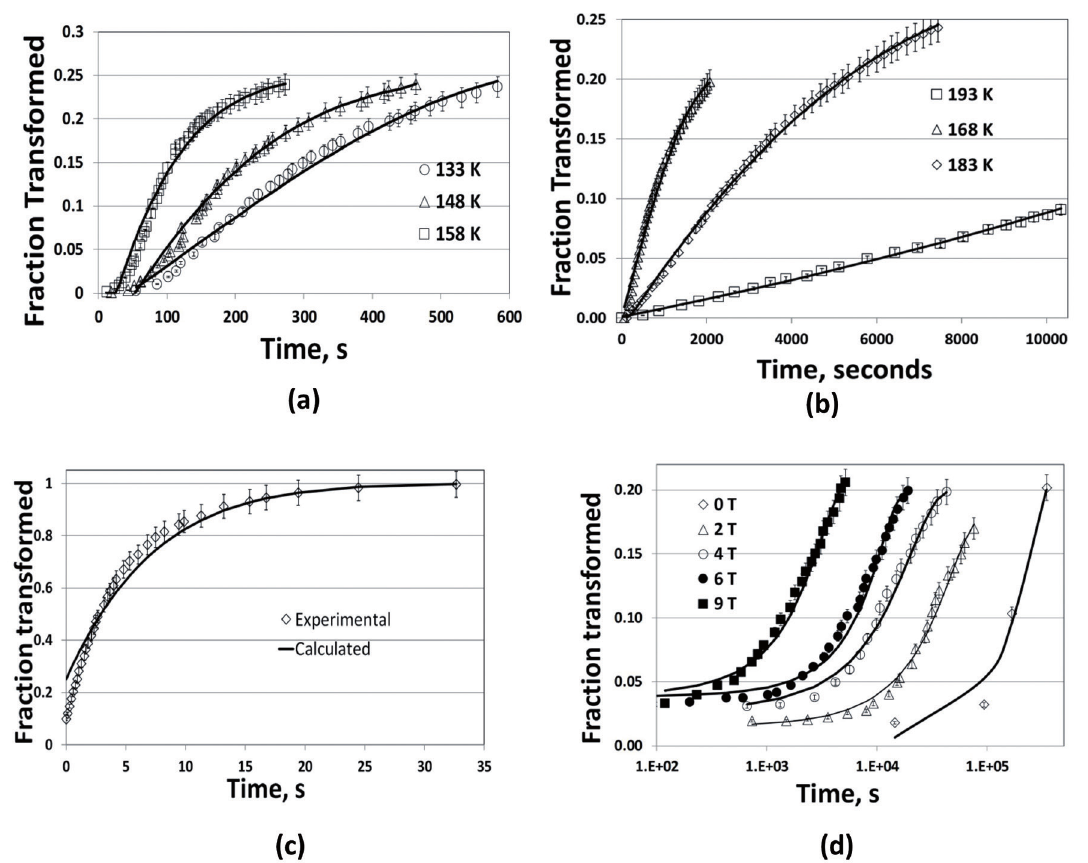
Figure 1: Time-dependent transformations (See Table 1)- (a-b) Isothermal martensite transformation curves of a Fe-Ni-Mn alloy 19 ; (c) Fe-1.5wt%Mn-1.5wt%-Si-0.3wt%Al-0.2wt%C 27 ; (d)Fe-12wt%Cr-9wt%Ni - 4wt%Mo-2wt%Cu 32 .